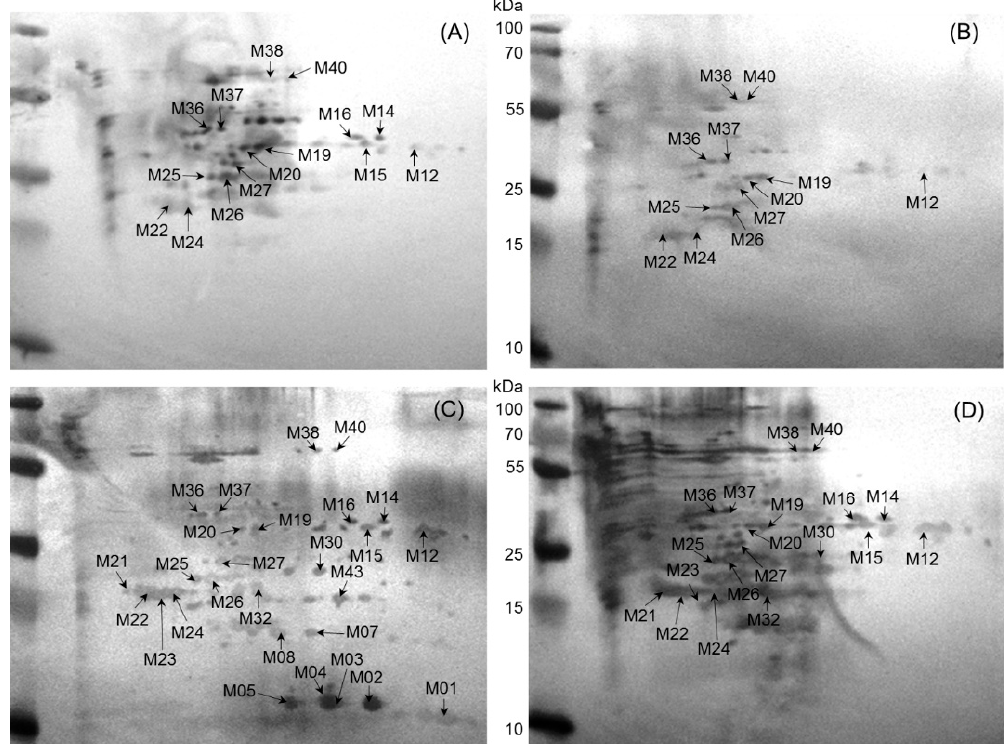
Figure 3. Representative 2D-PAGE immunoblotting images of whole cell proteins from B. melitensis field strain extracts separated on a 12% polyacrylamide gel. The blot was developed using the TMB kit after immuno-blotting with serum from ( A ) cattle; ( B ) buffalo; ( C ) sheep; and ( D ) goat and the respective peroxidase-conjugated secondary antibodies.